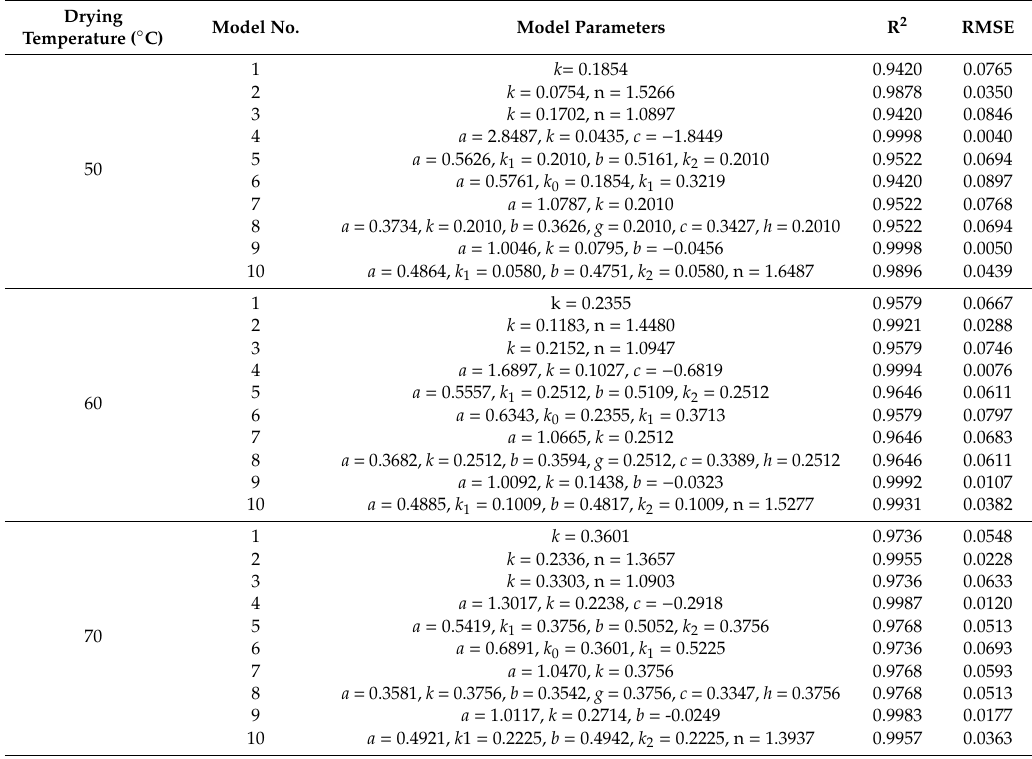
Table 5. Statistical evaluation of the mathematical drying models for persimmon samples of 8 mm thickness for VD.